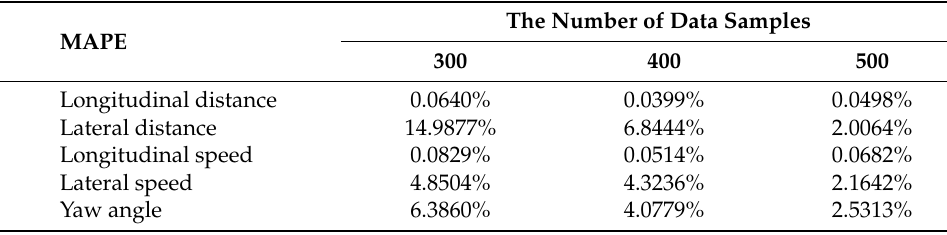
Table 4. Comparison of different sample size